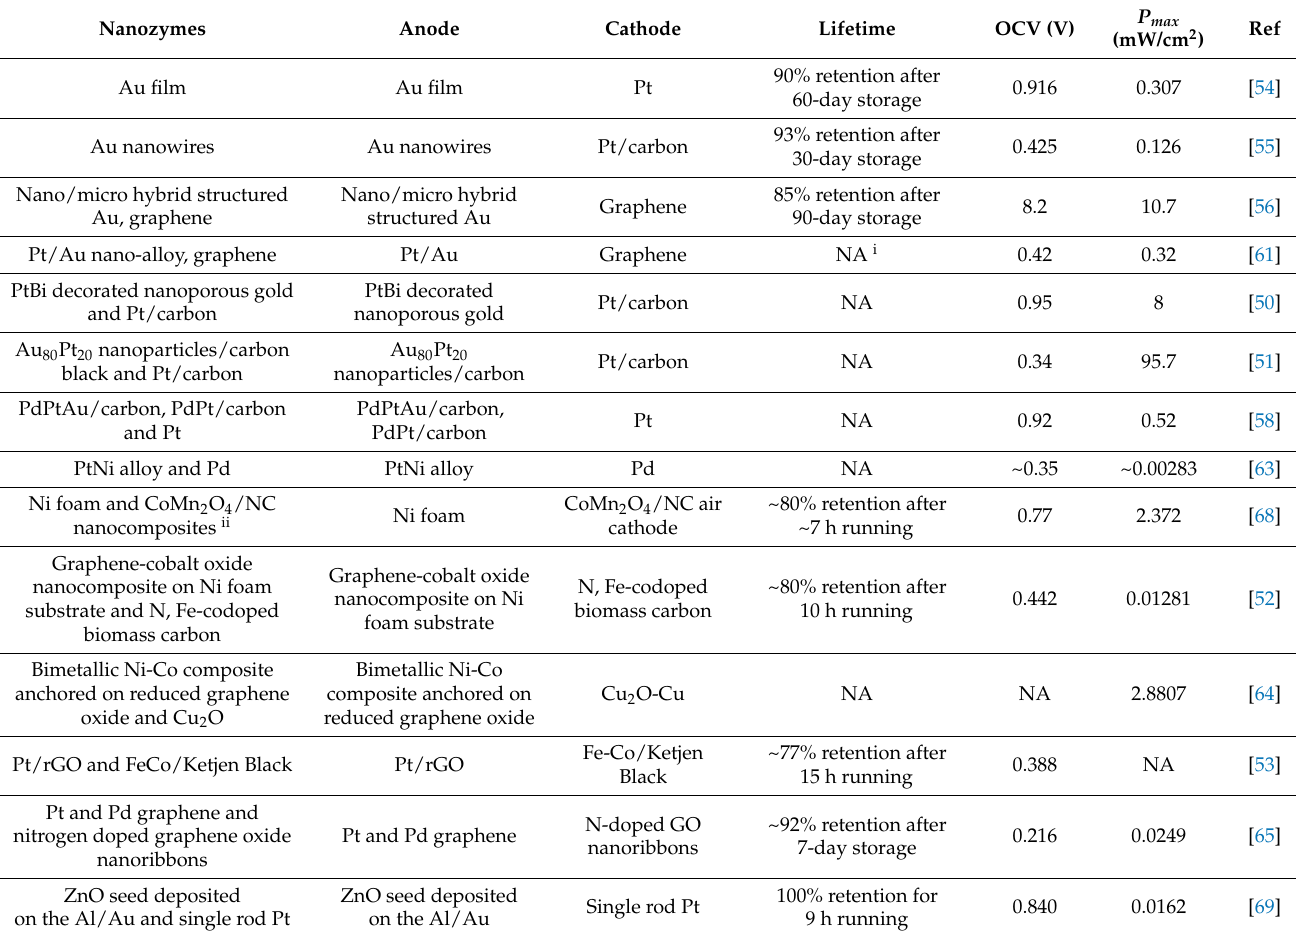
Table 1. Diverse studies on nanozyme-based glucose biofuel